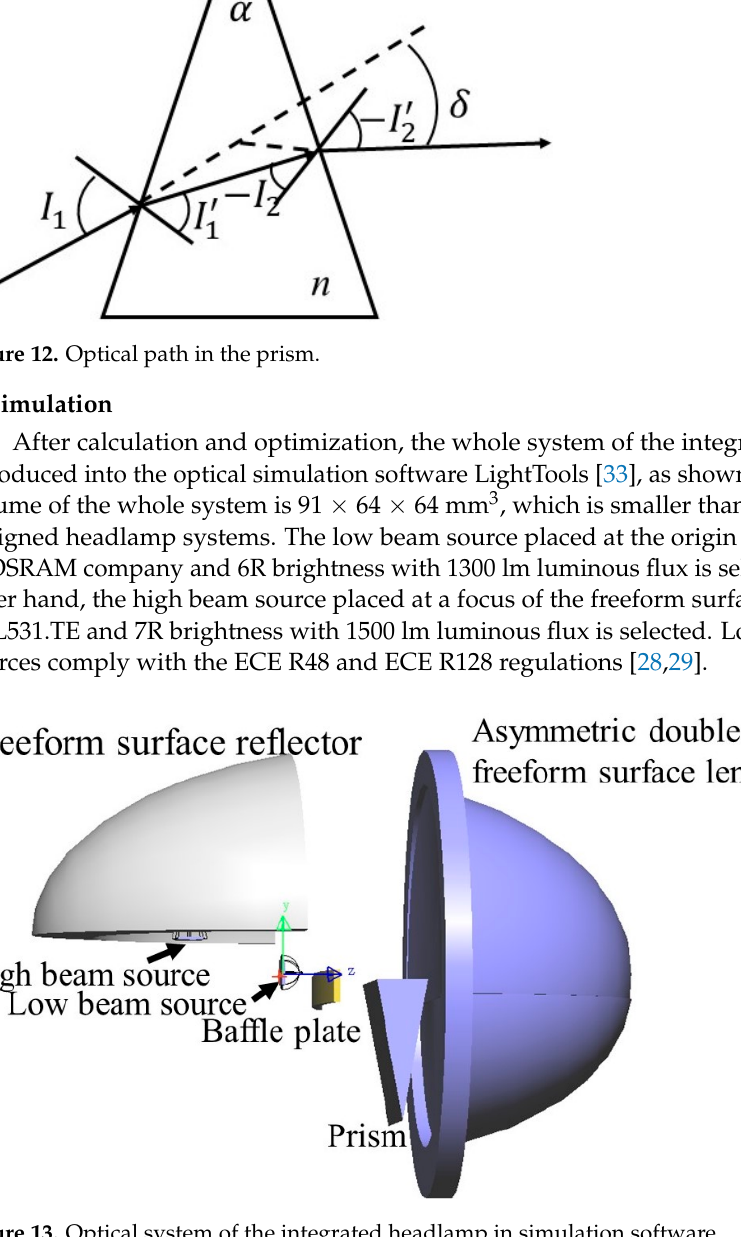
Figure 13. Optical system of the integrated headlamp in simulation software.